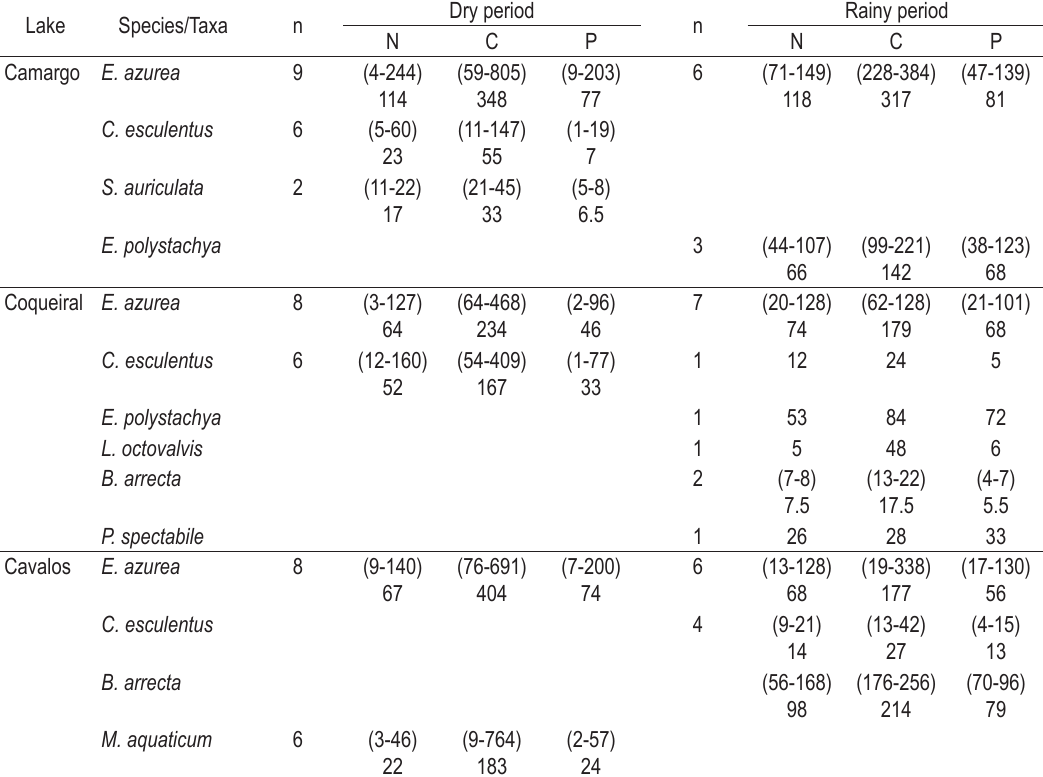
Table 4. Ranges (between parentheses) and means of nitrogen (N), carbon (C), and phosphorus (P) stocks (g.m -2 ) of aquatic macrophytes sampled in Camargo, Coqueiral, and Cavalos Lakes in dry and rainy periods (n = number of sampled